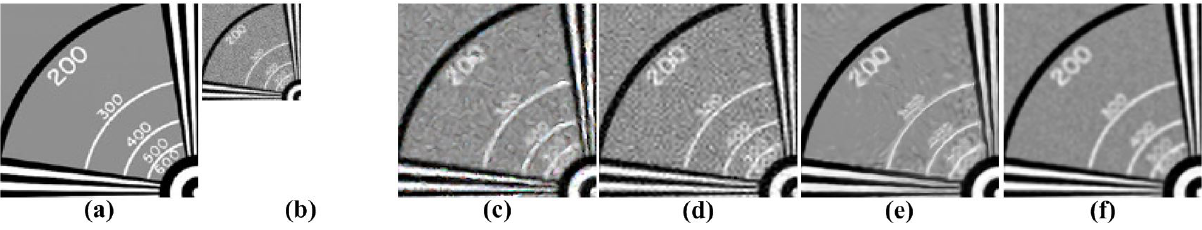
Results of resolution enhancement by enlarging a simulated noisy LR